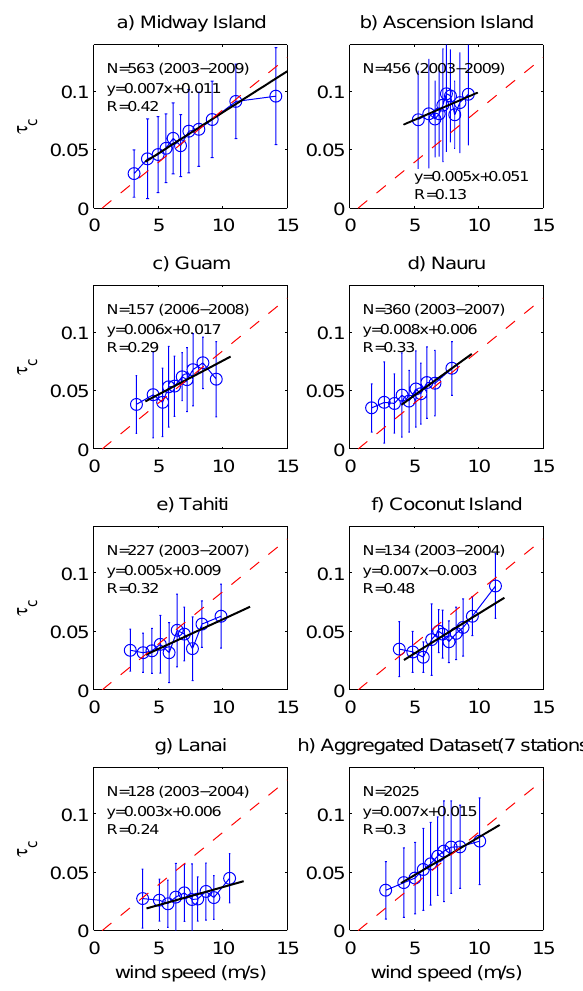
Fig. 7. Coarse aerosol optical depth from seven AERONET sta- tions on remote mid-latitudes and equatorial islands, plotted against AMSR-E W , a–g ) separately for each station; and h ) as an aggre- gated dataset. The data were sorted according to W and divided into 10 bins of equal number of observations. The regression equations and correlation coefficients were calculated from the full cloud of data points before binning. Circles and error bars represent respec- tively the mean and standard deviation of aerosol data within each bin. The dashed red line marks the empirical linear relationship be- tween MODIS τ c and AMSR-E W , corresponding to τ c 0 of 0.03 and a slope of 0.009s/m (see